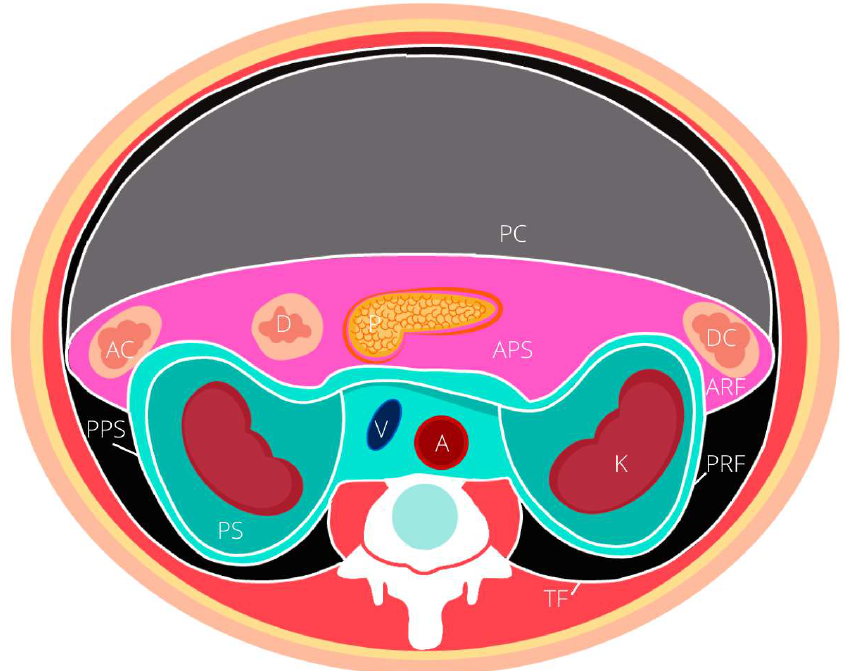
Figure 1. Schematic representation of the retroperitoneal perinephric compartments. ARF anterior renal fascia, PRF posterior renal fascia, TF transversalis fascia, APS anterior pararenal space, PPS posterior pararenal space, PS pararenal space, V vena cava, A abdominal aorta, D duodenum, AC ascending colon, DC descending colon, P pancreas, PC peritoneal cavity.